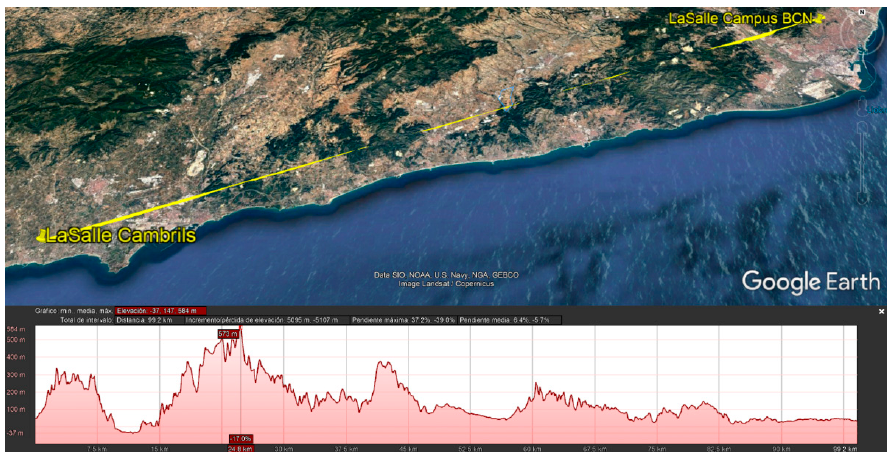
Figure 5. NVIS link between LaSalle Campus, BCN and Cambrils, Tarragona. The highest peak is located at 573 meters above sea level.